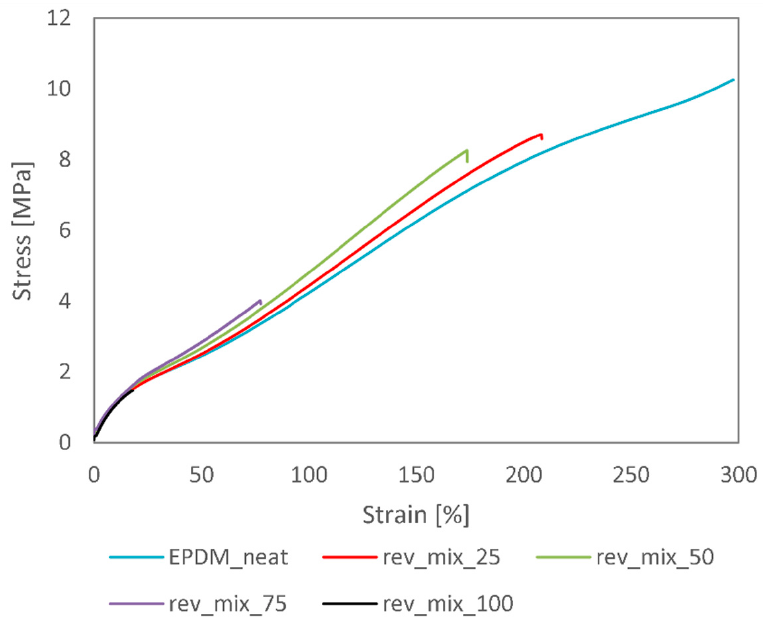
Figure 4. Characteristic stress–strain curves for the EPDM revulcanisates.